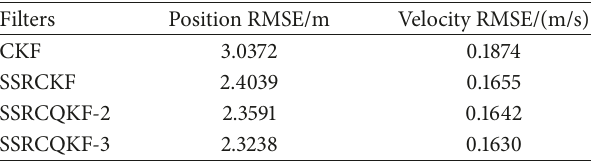
Table 3: Average RMSE of various